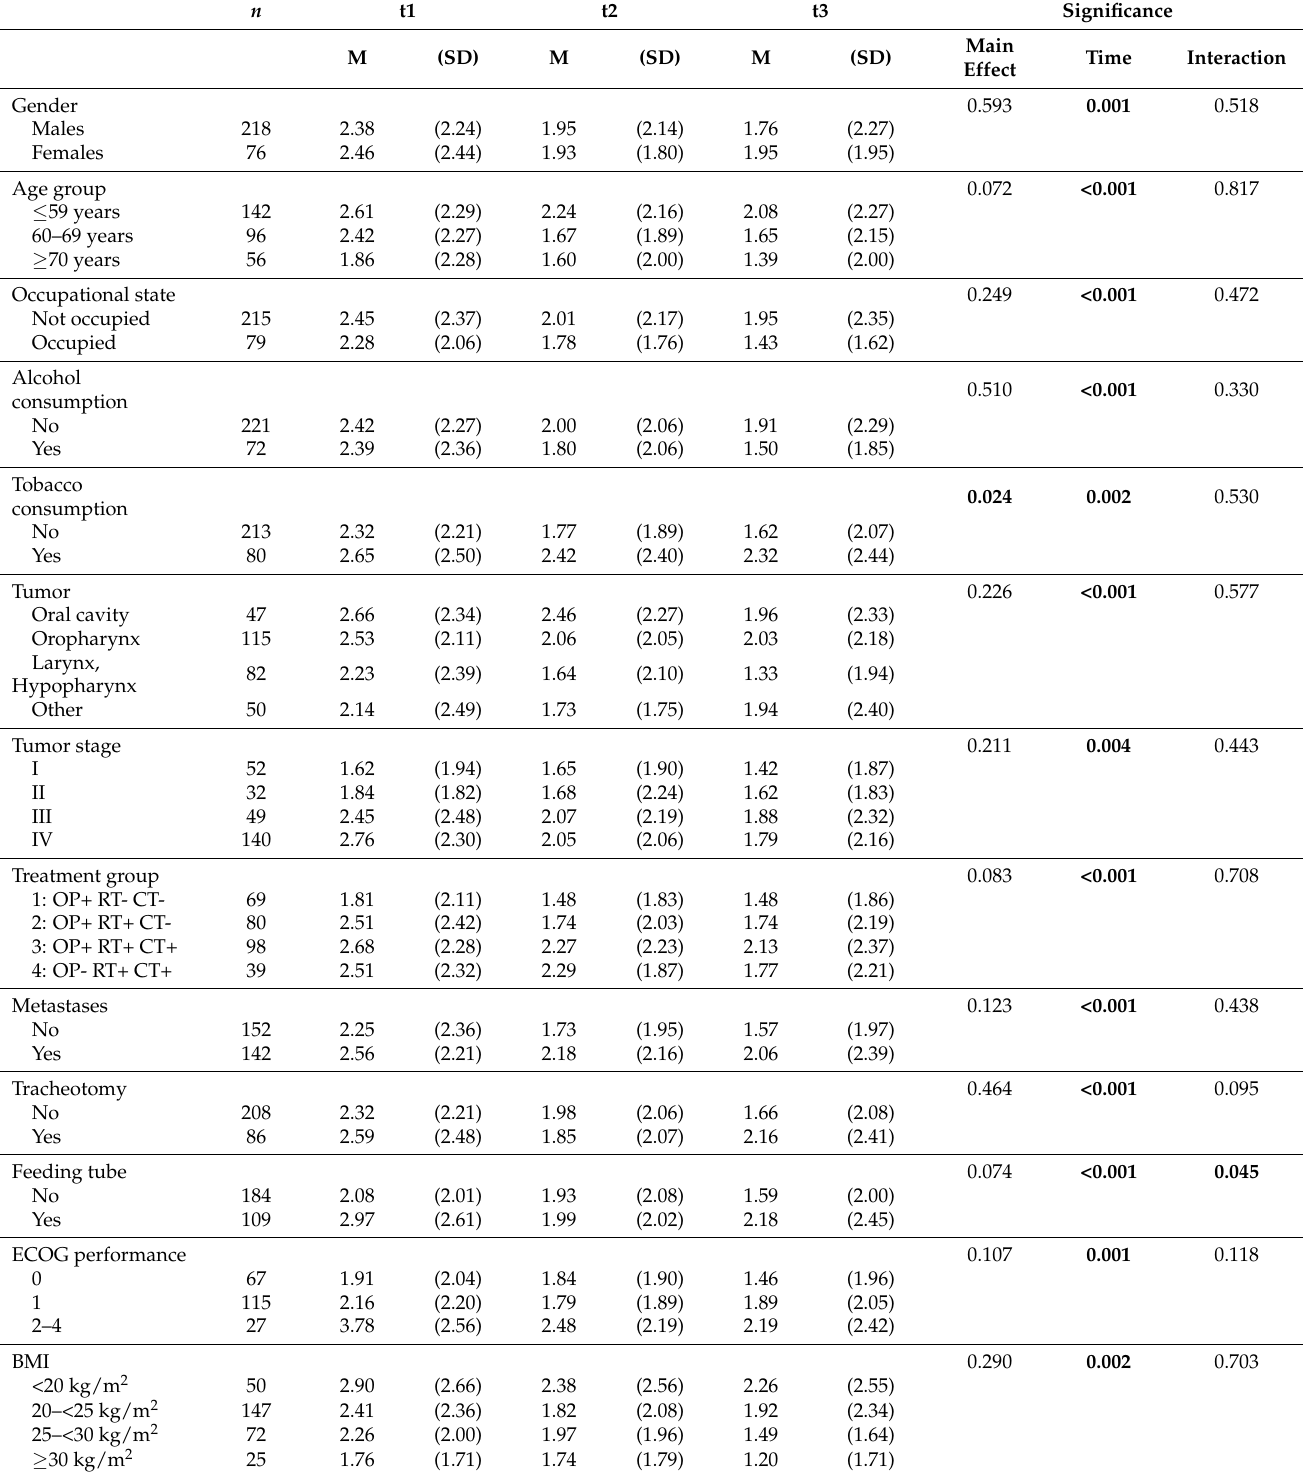
Table 5. Pain ( n = 294): Mean scores depending on sociodemographic and clinical